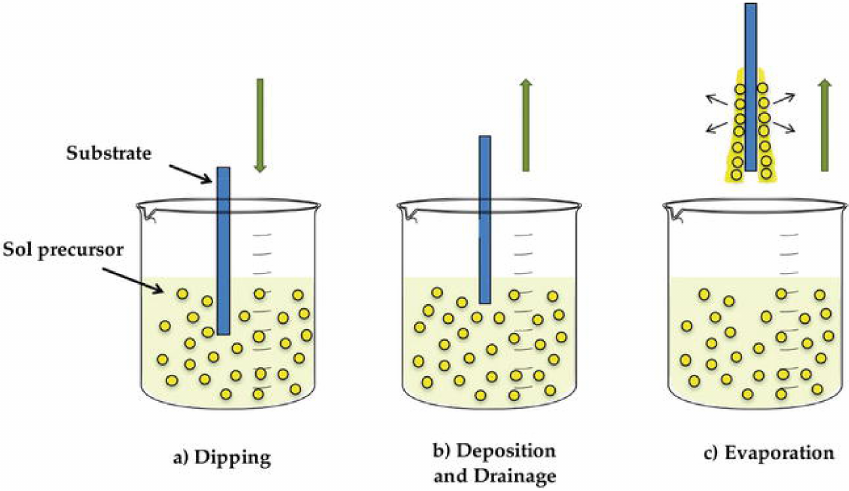
Figure 11. Schematic of the processes controlling thin-film formation in fast- and slow-rate deposition. Reprinted with permission from